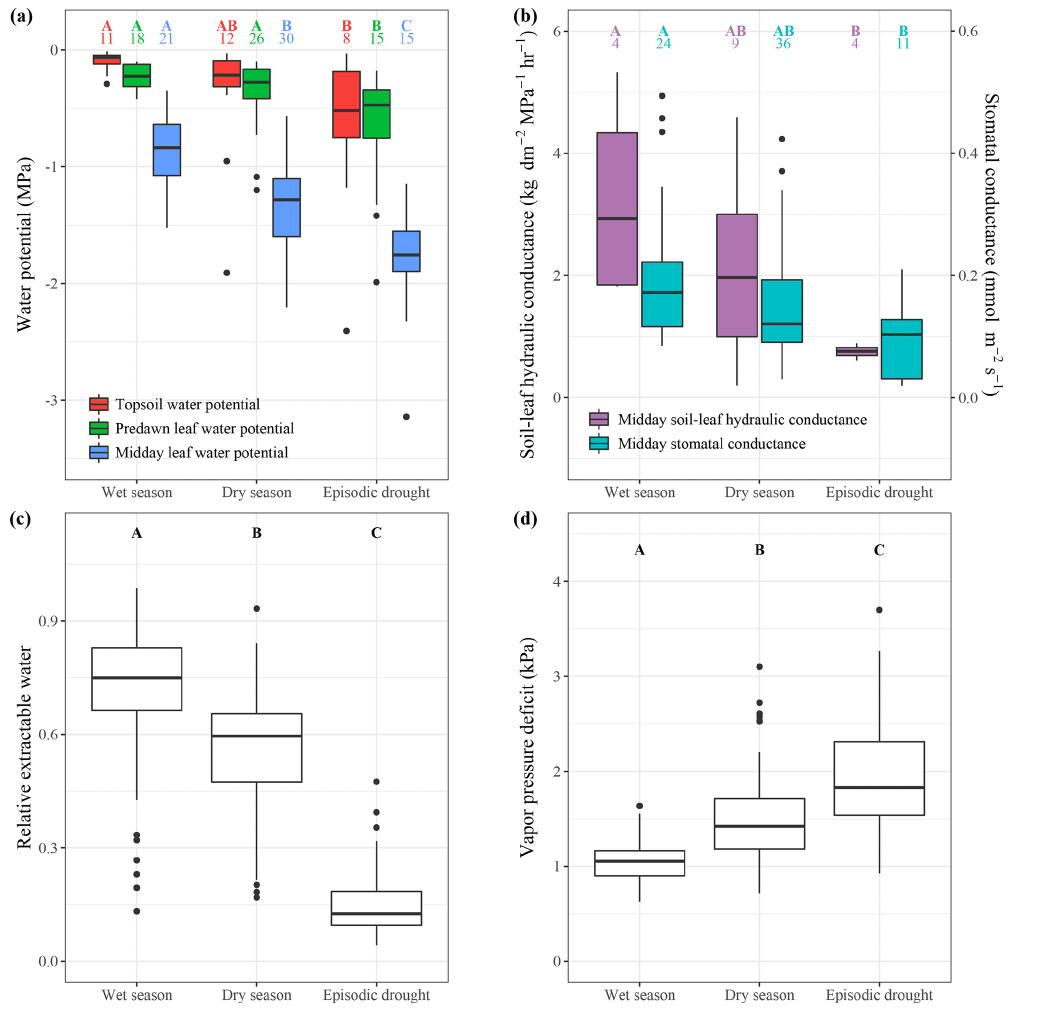
Figure 2. Plant hydraulic status, plant hydraulic conductance, stomatal conductance and environmental drivers in the wet season, dry season and during episodic drought. The boxplots show the median value and interquartile ranges (boxes); the whiskers show the range between minimum and maximum value, and, if present, outliers are indicated as single dots. Soil matric potential, predawn leaf water potential, midday leaf water potential (a) , soil-to-leaf hydraulic conductance and stomatal conductance (b) are derived from published data and available in the supplementary database. The numbers above the boxplots in (a) and (b) denote the number of unique source and site combinations at which the variables were averaged. Relative extractable water (c) and vapour pressure deficit (d) are derived from monthly ECMWF ERA5 reanalysis data extracted for 229 Neotropical forest sites in South and Central America (1979–2019). Capital letters indicate a significant ( p< 0 . 05, Tukey’s honestly significant difference test pairwise difference between the wet season, dry season and episodic-drought values. When a group is not significantly different from the two other groups that are significantly different in the comparison, the capital letters are